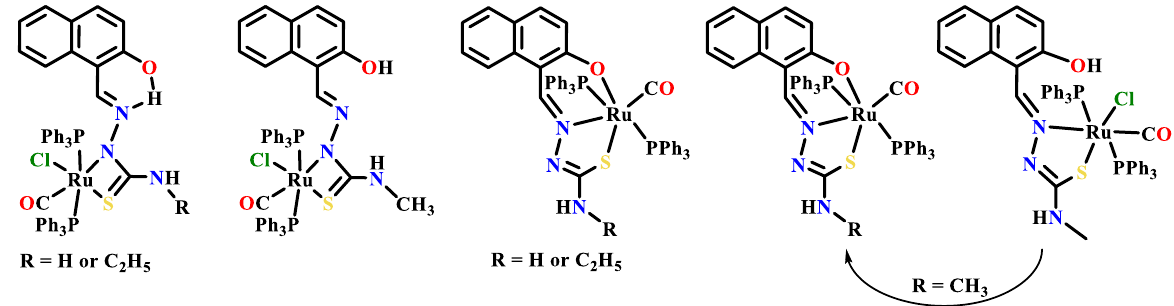
Figure 34. A series of Ru(II) complexes of naphthylhydrazone with thiourea/methylthiourea/ethyl- thiourea as the side chain, reported by R. Prabhakaran’s